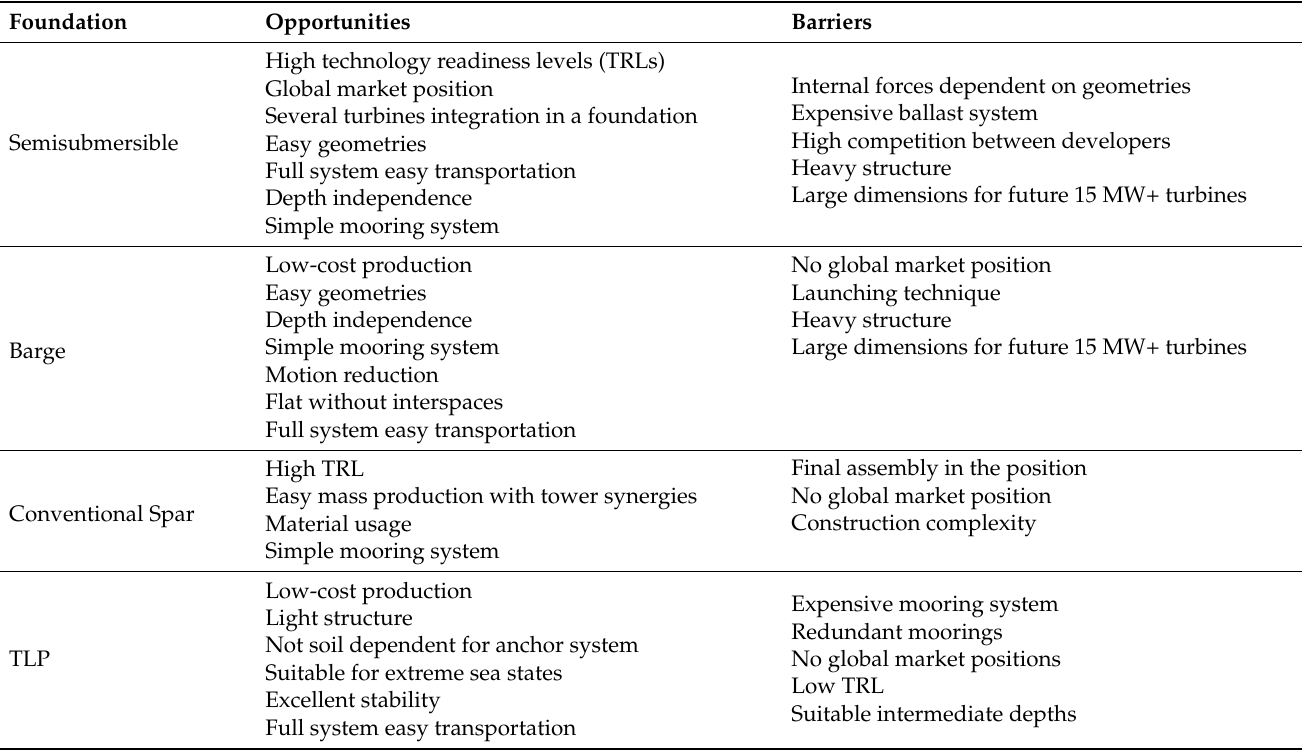
Table 1. Main opportunities and barriers of floating